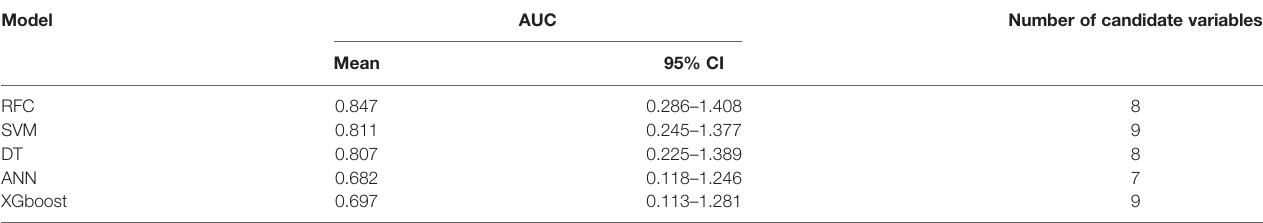
TABLE 2 | Receiver operating characteristic curve analysis for predicting response to neoadjuvant chemotherapy in each machine learning-based model.